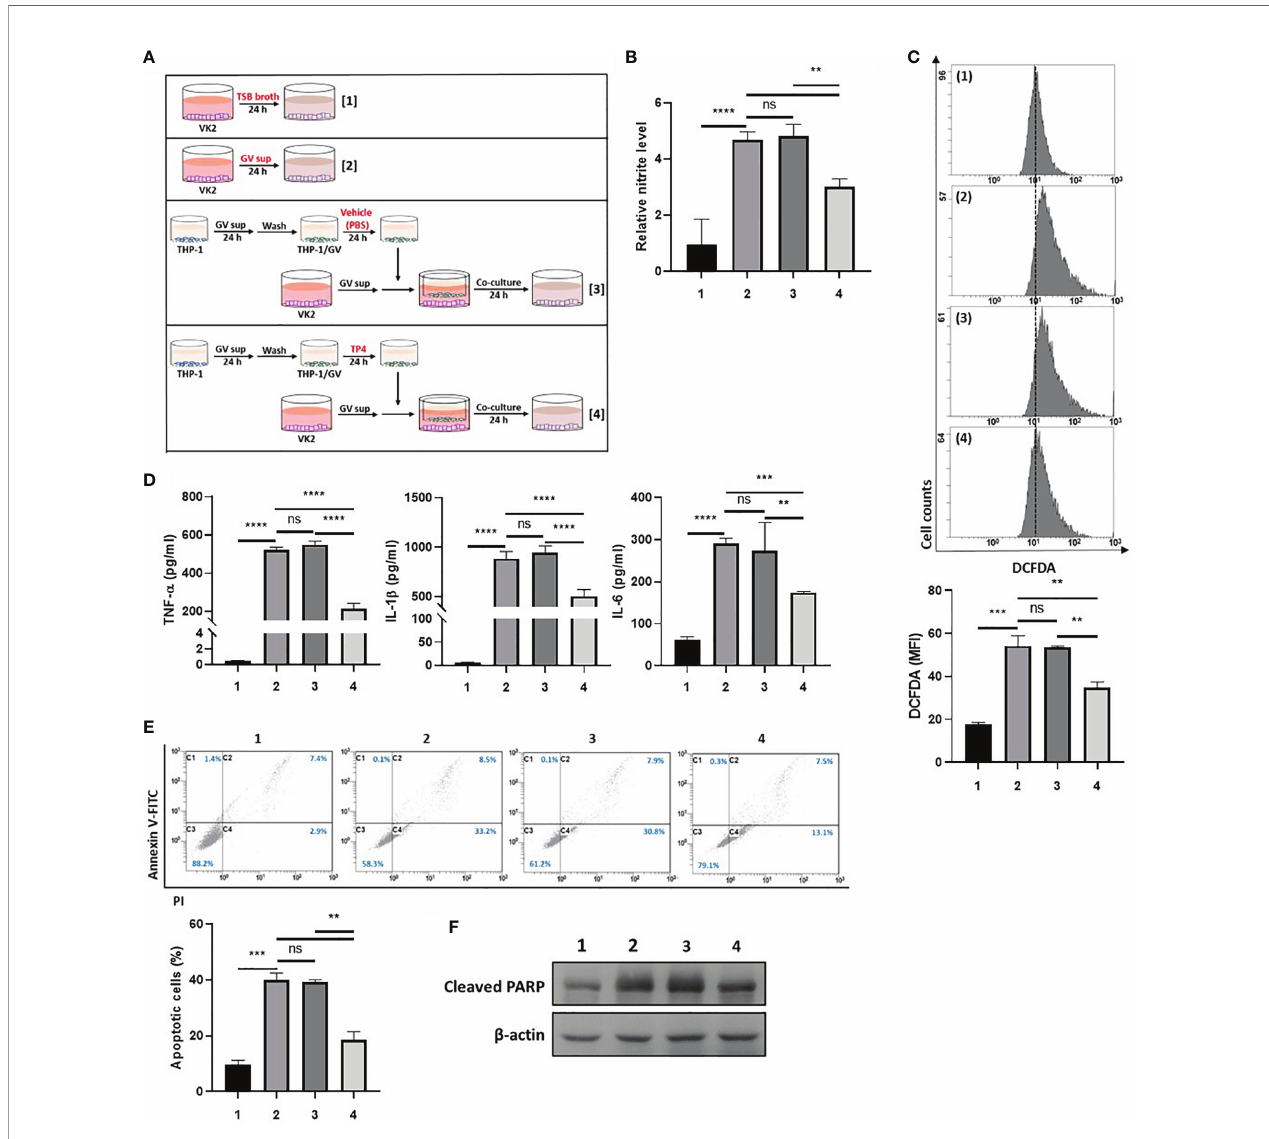
FIGURE 4 | TP4-induced M2c macrophages attenuate GV sup-induced in fl ammation and cell death in VK2 cells. (A) Schematic description of the treatment methods. VK2 cells were treated with [treatment 1] TSB broth or [treatment 2] 10% (v/v) GV sup and co-cultured with THP-1/GV cells that had been pre-treated with [treatment 3] vehicle (PBS) or [treatment 4] TP4 (7.82 µg/ml) followed by incubation with serum-free medium. (B) The nitric oxide (NO) levels in VK2 cells were assayed by the NO assay. (C) The reactive oxygen species (ROS) levels in VK2 cells were measured by DCFDA assay using fl ow cytometry. The mean fl uorescence intensity (MFI) is shown in the bar graphs. (D) The secretion of TNF- a (left), IL-1 b (middle), and IL-6 (right) by the VK2 cells were measured by MultiPlex assay. (E) The treated cells were double-stained with PI and Annexin V and analyzed by fl ow cytometry. Four populations were identi fi ed: necrotic cells (C1), late apoptotic cells (C2), viable cells (C3), and early apoptotic cells (C4). Apoptotic cell percentage was quanti fi ed as the sum of C2 and C4 over total cell number × 100. Data are presented as mean ± SD of three independent experiments (**P < 0.01; ***P < 0.001; ****P < 0.0001; ns, not statistically signi fi cant). (F) Poly (ADP-ribose) polymerase (PARP) cleavage was detected by immunoblotting after co-culture. b -actin was used as an internal control to show equal protein